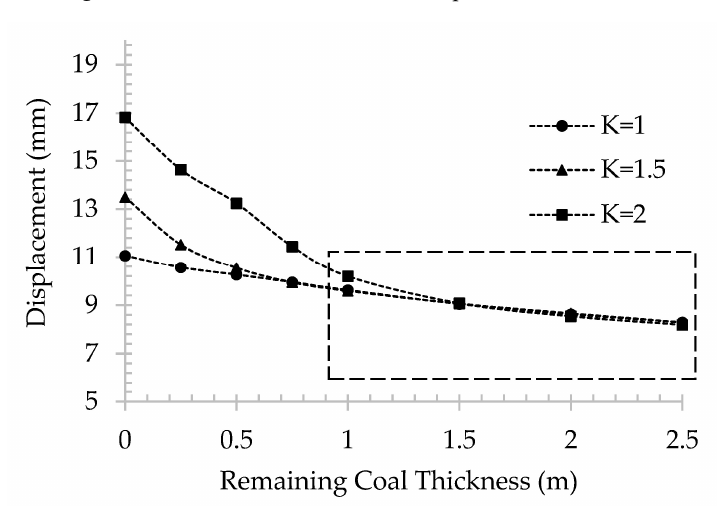
Figure 10. Correlation between roof displacements and RCT.